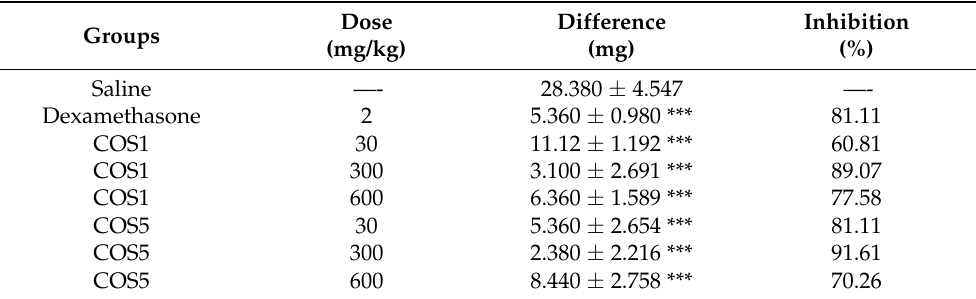
Table 4. Antiedematogenic effects of chitooligosaccharides (COS1 and COS5) after 1 and 5 min of hydrolysis in the xylene-induced ear edema model.